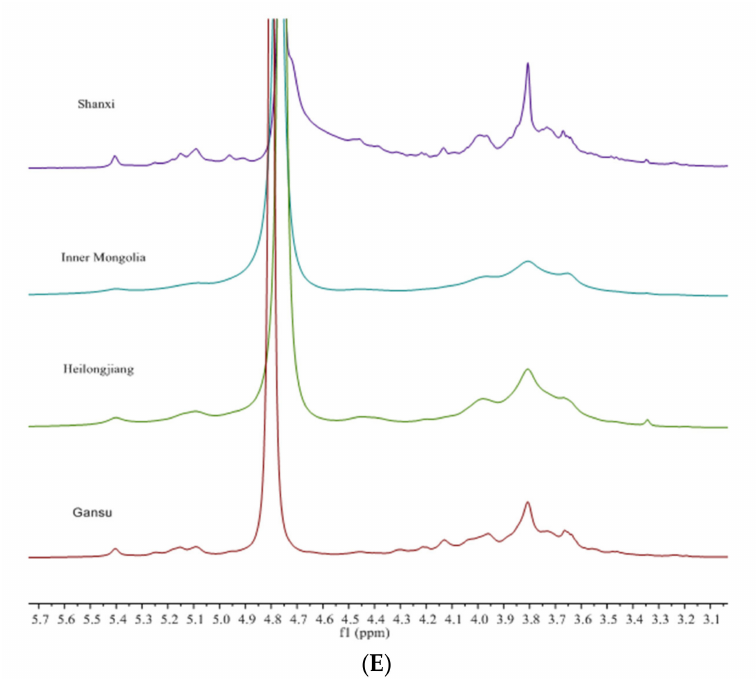
Figure 5. NMR spectra of APS. ( A ), HSQC spectra of APS from Gansu; ( B ), HSQC spectra of APS from Heilongjiang; ( C ), HSQC spectra of APS from Shanxi; ( D ), HSQC spectra of APS from Inner Mongolia; ( E ), 1 H spectra of four APS